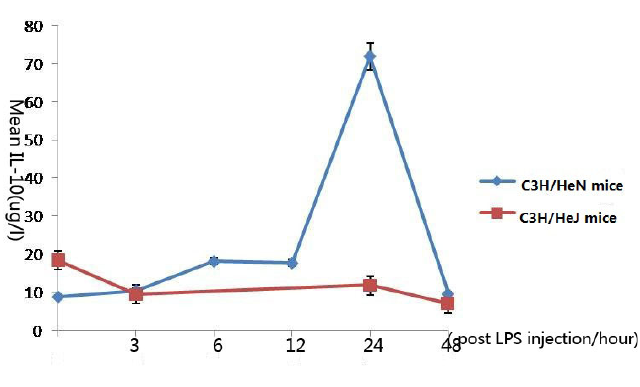
Figure 4. The expression levels of interleukin-10 in the aqueous humor at different time points (expressed as the mean μ g/L ± SD). In C3H/HeN mice, IL-10 reached a peak concentration 24 h after injection, and returned to its original concentration 48 h after injection . The peak concentration of interleukin-10 in C3H/HeJ mice is the control group; after LPS injection, the concentration decreased gradually, but 24 h after injection, the concentration reached its second peak, then